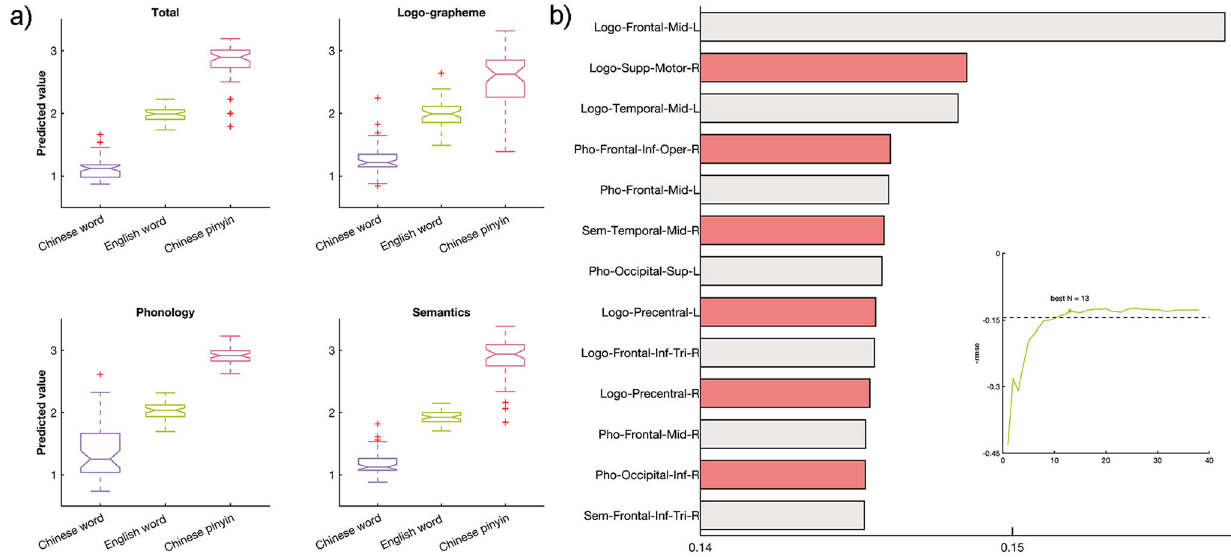
Fig. 4 Separate brain activity patterns of linguistic components across language types revealed by the support vector regression model. a The prediction results of language types with the brain activity elicited by language-processing components in 30 ROIs as input features. b The bars indicate the contributions of regions to the model obtained from a recursive feature elimination scheme. The plot indicates the best number of features for classi fi cation. Abbreviations, Logo Logo-grapheme, Pho Phonology, Sem